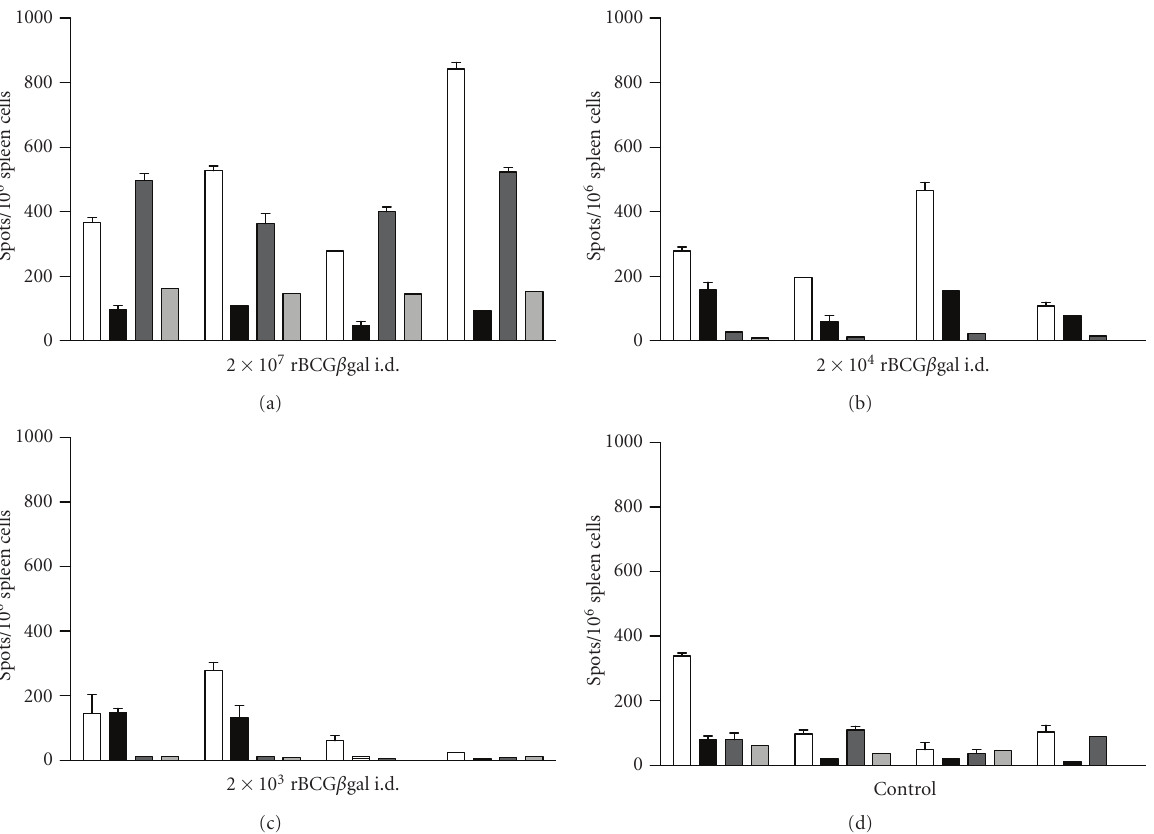
Figure 3: Immune response of individual mice vaccinated with di ff erent doses of rBCG β gal after subsequent i.d. challenge with a high dose of rBCG β gal. Each group of mice was initially given an i.d. vaccination dose of rBCG β gal as indicated below each graph with a control group receiving challenge dose only shown. After 4 months, the mice were challenged with approximately 2 × 10 7 rBCG β gal cfu given i.d. After an additional 16 weeks, the mice were killed and the number of β -gal- and BCG-specific IFN γ - and IL-4-producing cells in their spleens was determined by ELISPOT assay. Open bars—IFN γ response to BCG; Black bars—IFN γ response to β -gal; Dark gray bars—IL-4 response to BCG; Light gray—IL-4 response to β -gal. All values were corrected for background by subtracting the number of spots observed in wells without antigen. Results are representative of two independent experiments.